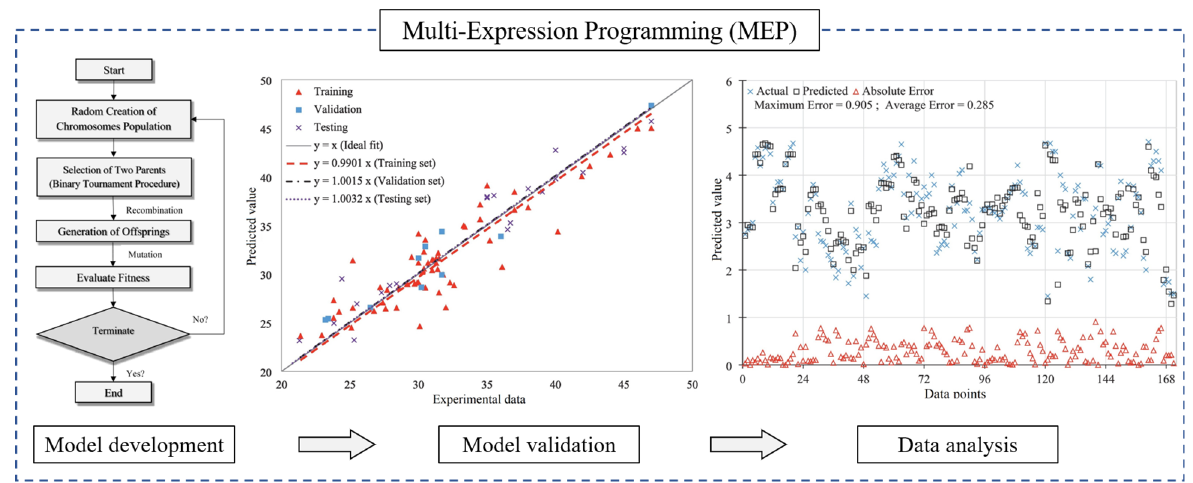
Figure 10. Schematic diagram of electrochemical deposition device for reinforced concrete structures. Adapted from [81, 82]